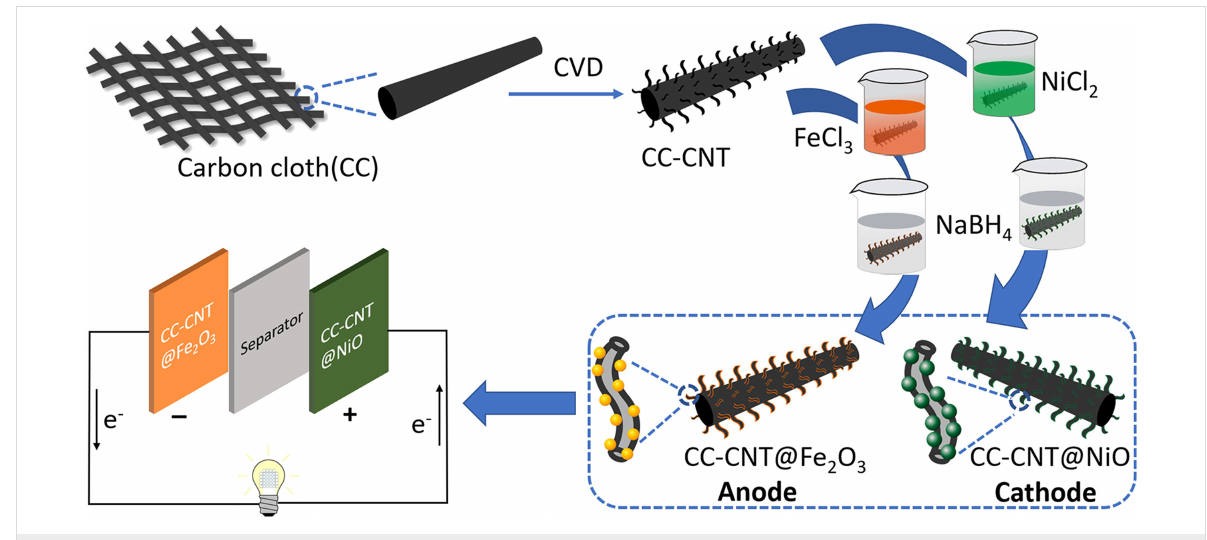
Figure 1: Schematic illustration of the preparation of the asymmetric supercapacitor.